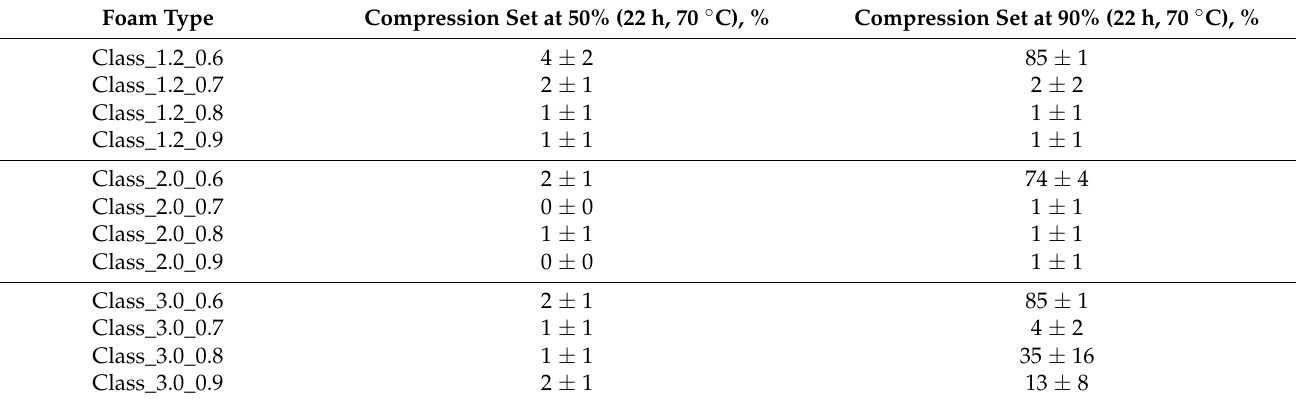
Table 8. Compression set at 50% and 90% for different I NCO and water content levels.